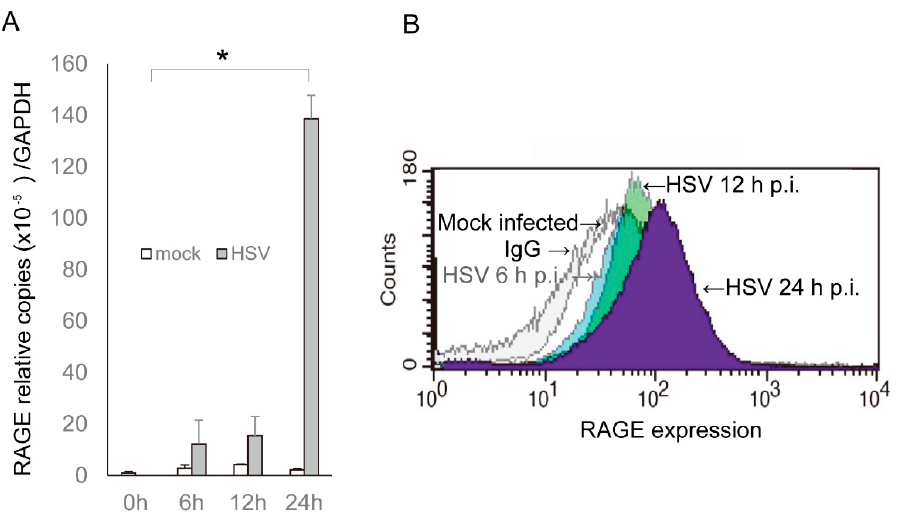
Figure 2. Induction of RAGE expression after HSV-1 infection. HCEn cells were infected with HSV-1 at multiplicity of infection (MOI) of 1 and evaluated for the expression of RAGE. ( A ) The induction of the mRNA of RAGE determined by real-time RT-PCR is significantly increased and peaked at 24 h post infection. *: p < 0.00001. n = 4. ( B ) Cell surface expression of RAGE after HSV-1 infection was assessed by FACS analysis. RAGE expression is increased after infection and peaked at 24 h. Mean signal intensity of RAGE was 26 ± 1 (mock), 55 ± 3 (6 h, p = 0.001), 117 ± 6 (12 h, p = 0.000), and 149 ± 7 (24 h, p = 0.000). n =